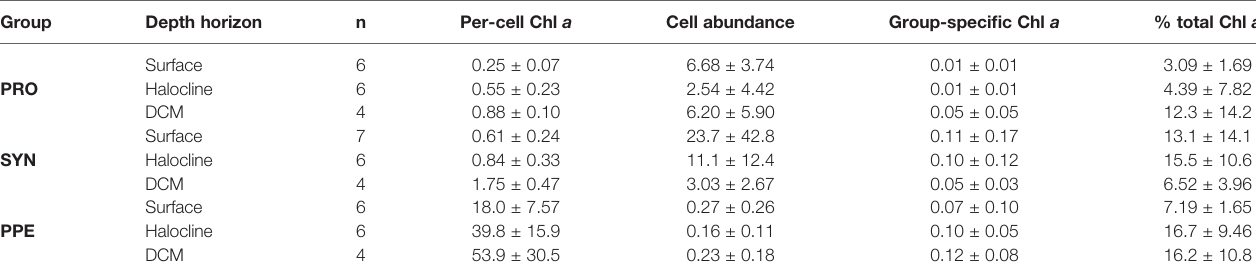
TABLE 1 | Summary of values for per-cell Chl a (fg Chl a cell -1 ), cell abundance (1 x 10 10 cells m -3 ), group-speci fi c Chl a (mg Chl a m -3 ), and group-speci fi c Chl a fractions (% total Chl a ) for Prochlorococcus (PRO), Synechococcus (SYN), and picophytoeukaryotes (PPE) in fi eld samples grouped by depth horizon. Group